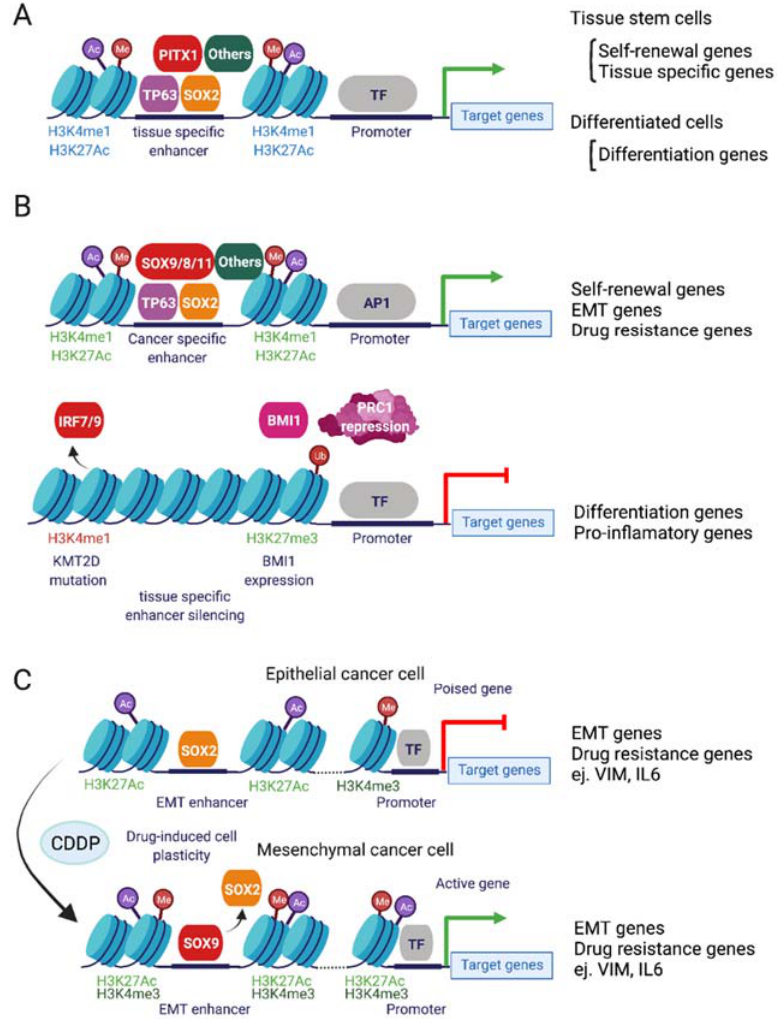
Figure 3. Epigenetic reprogramming in cisplatin-resistant HNSCC. ( A ) In physiological conditions, tissue homeostasis is supported by the expression of the TFs PITX1, TP63 and SOX2. ( B ) In tumor initiation events, two different landscapes can occur. On one hand, overexpression of oncogenic TFs promotes chromatin accessibility to cancer-specific enhancers, which results in self-renewal, EMT and drug resistance genes increase. On the other hand, the loss of active marks (H3K4me1) and the gain of repressive marks (H3K27me3) near tissue-specific enhancers lead to the silencing of tissue differentiation and pro-inflammatory genes. ( C ) Tumors adapt to cisplatin by replacing SOX2 with SOX9 in EMT enhancers as well as the deposition of the H3K27Ac mark, allowing the expression of mesenchymal and drug resistance genes. Created with BioRender.com.